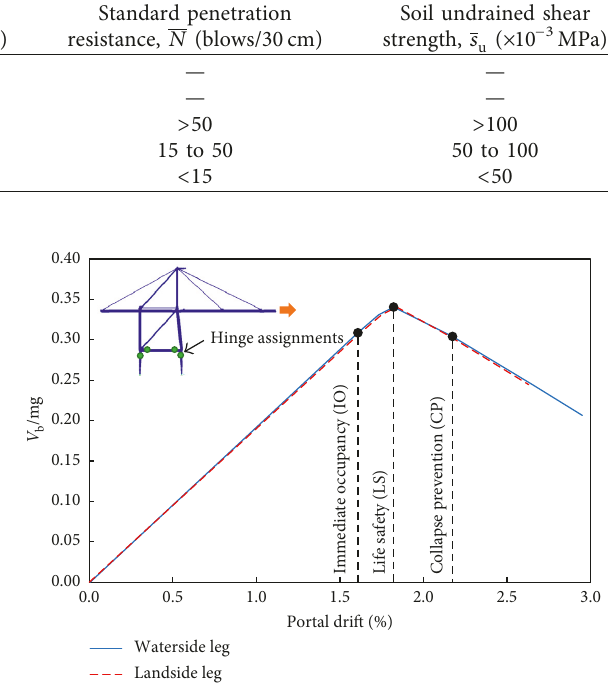
Figure 7: Pushover curve and limit states for typical Korean container